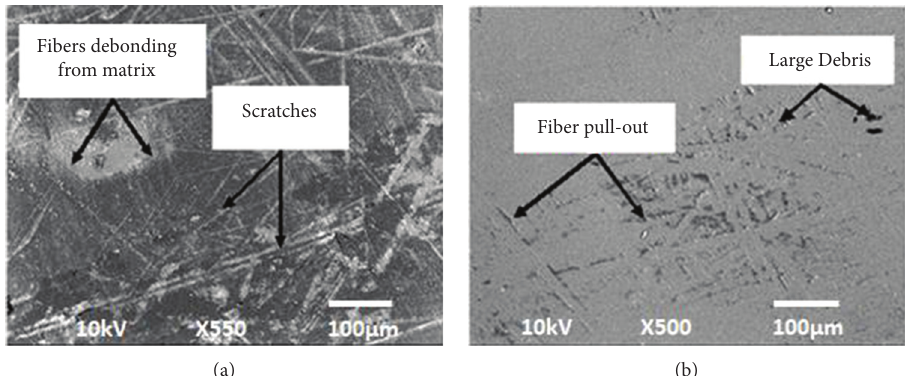
Figure 11: (a) SEM Micrograph of worn untreated polypropylene (U +PP) sample at 9.81N and (b) SEM micrograph of worn untreated polypropylene (U +PP) sample at 19.62N.